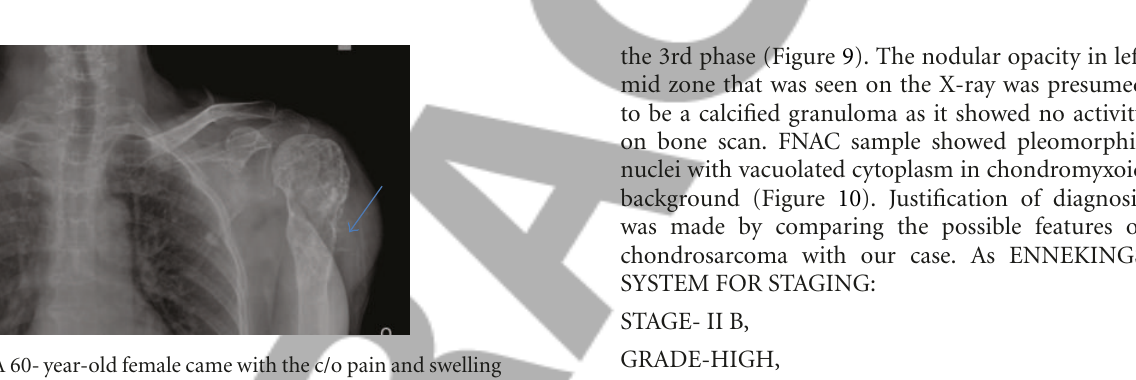
Figure 1: The picture is showing a 60 years old female who came with the c/o pain and swelling in upper arm.